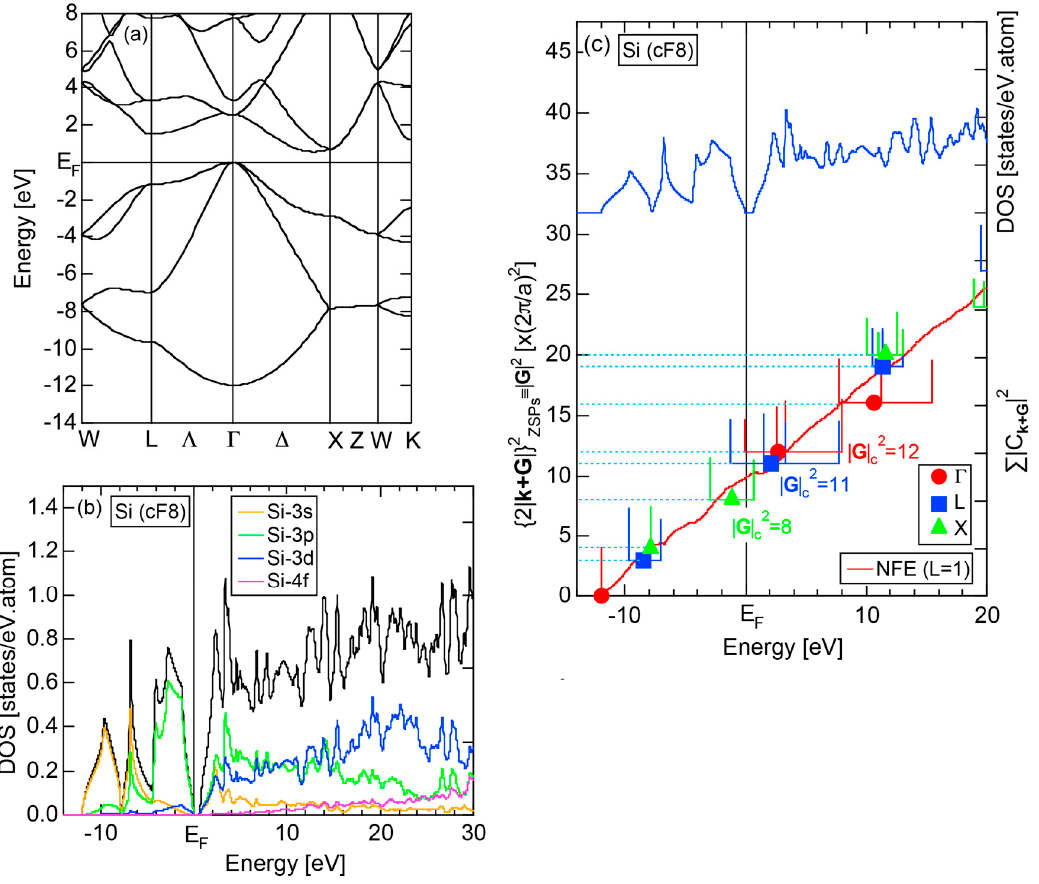
Figure 11. ( a ) Dispersion relations; ( b ) total- and partial-DOSs and ( c ) FLAPW-Fourier spectra at symmetry points Γ , L and X of the fcc Brillouin zone for Si (cF8). The total-DOS is incorporated in ( c ).